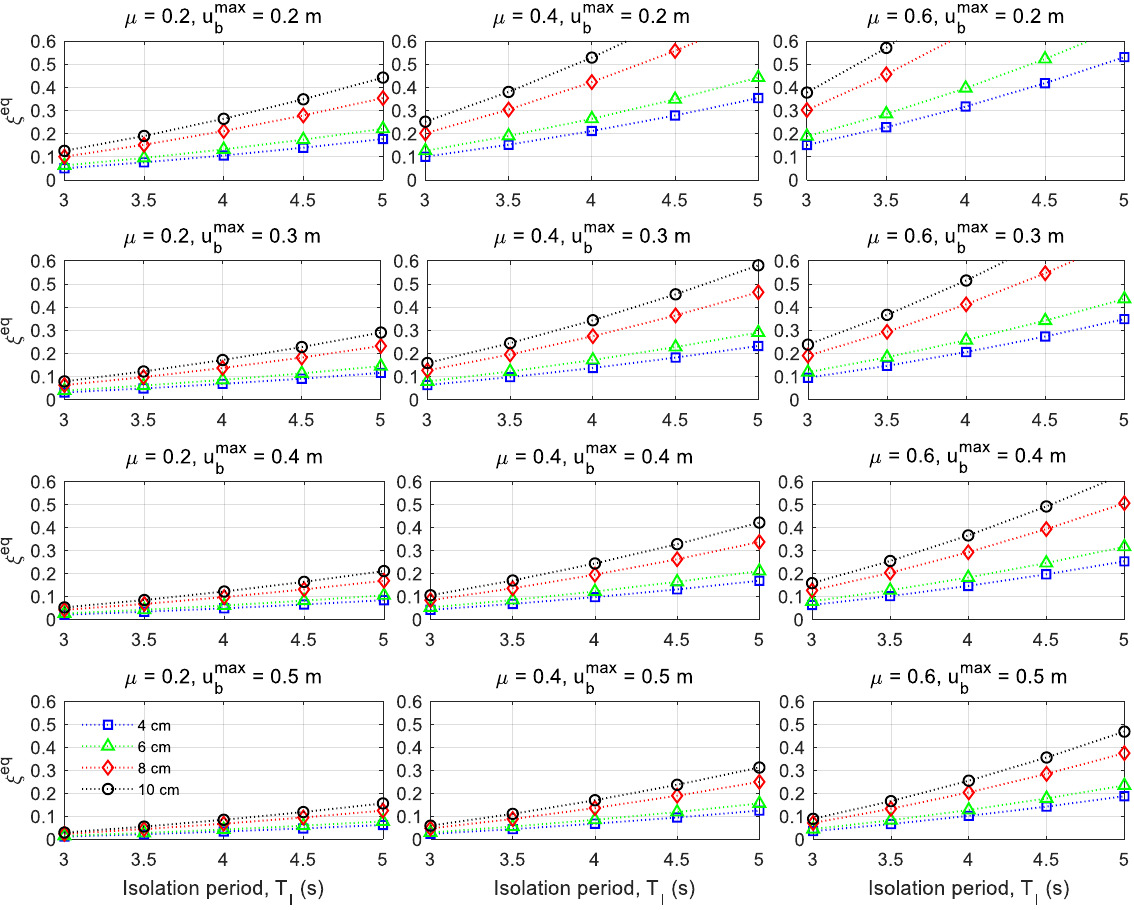
Figure 14. Equivalent damping ratio ( ξ eq ) of the isolation system considering different friction coefficients on the insulator ball joint ( μ ) and maximum basal displacement (𝑢 𝑏𝑚𝑎𝑥 ).